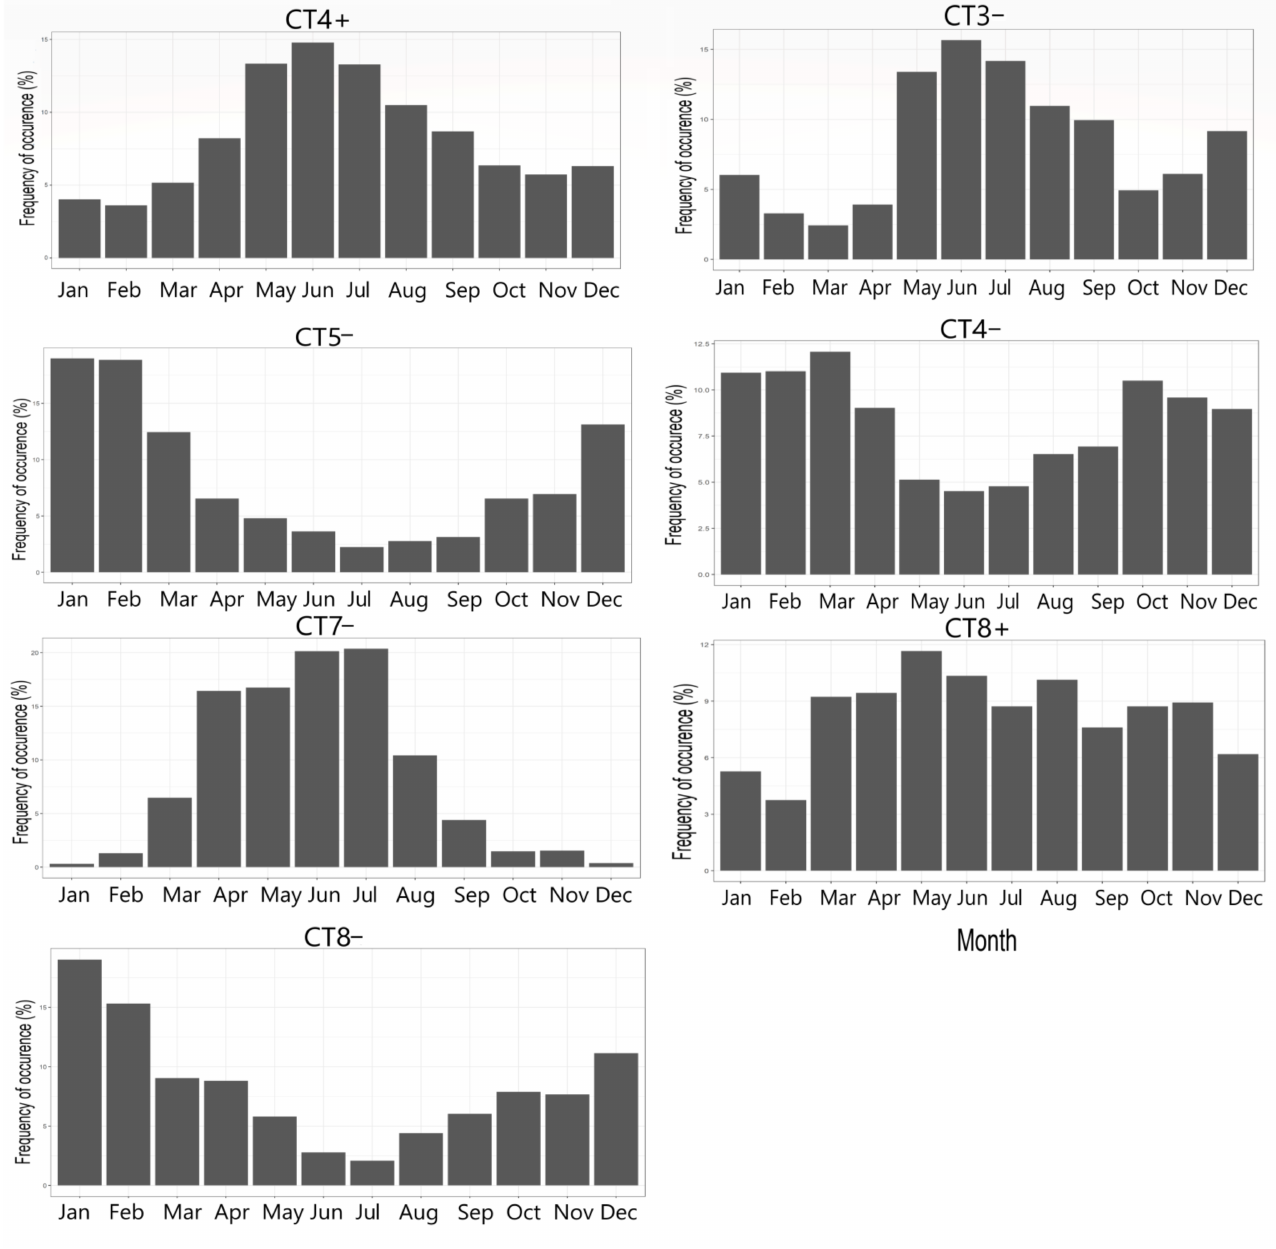
Figure 5. Annual cycle of the selected CTs associated wet days (right panel) and dry days (left panel) in the Western